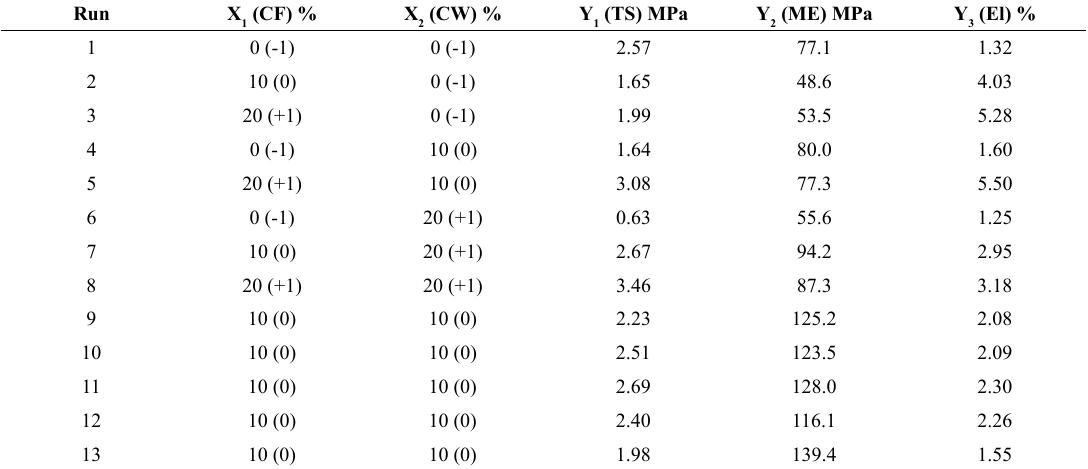
Table 1. Central composite design matrix with real and coded (in parentheses) values for independent variables, with X content (CF) and X = carnauba wax content (CW); and means for response variables, with Y 2 elasticity (ME) and Y = elongation at break (El). 3